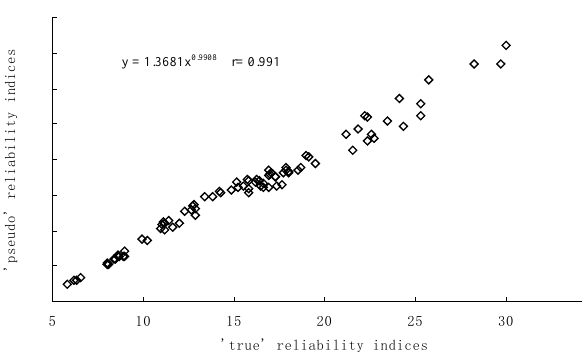
Figure 8. Cross section of the heterogeneous slope in example 2.